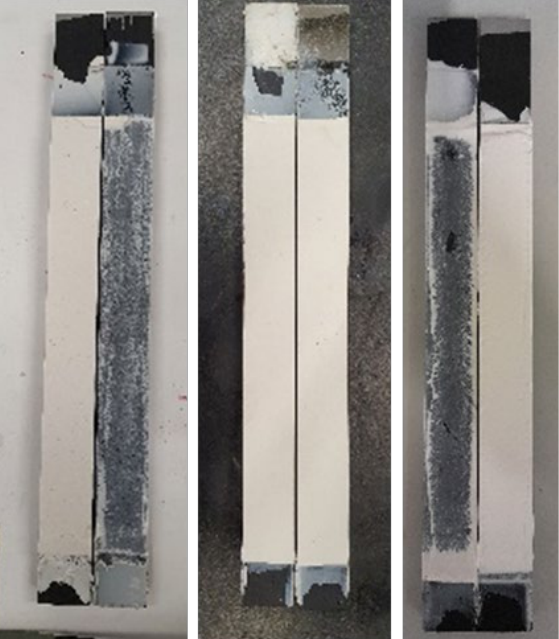
Figure 12. Fracture surfaces obtained under high loading rate (6000 mm/min) at, respectively, 23 °C ( left ), −3 0 °C ( middle ), and 60 °C ( right ).